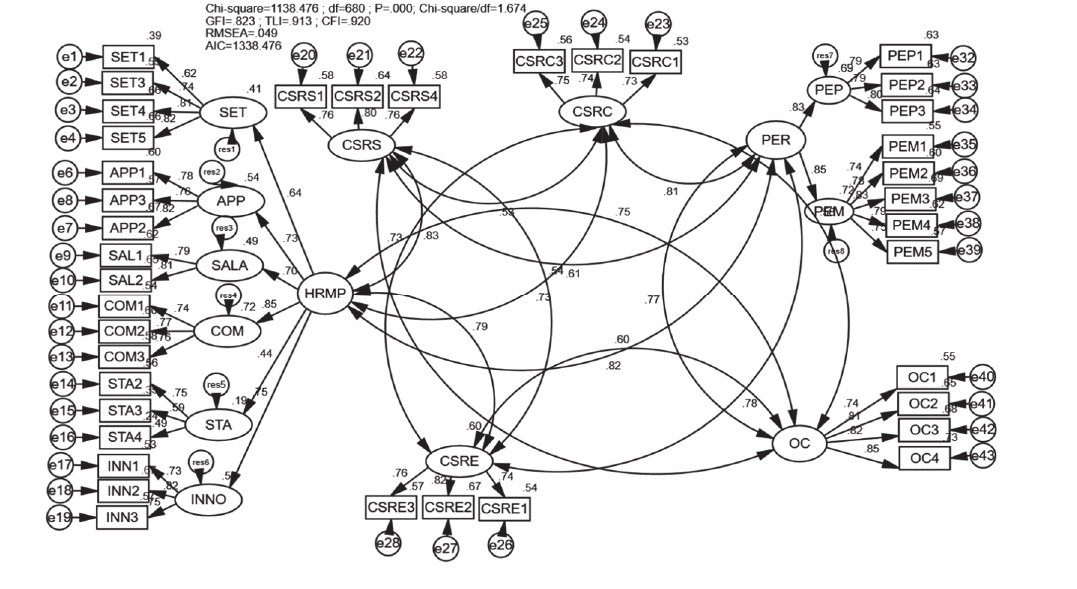
Fig. 2. The analysis result of the CFA critical